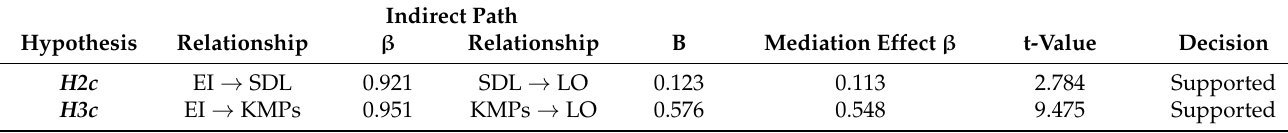
Table 8. Specific Indirect Effects (China sample).